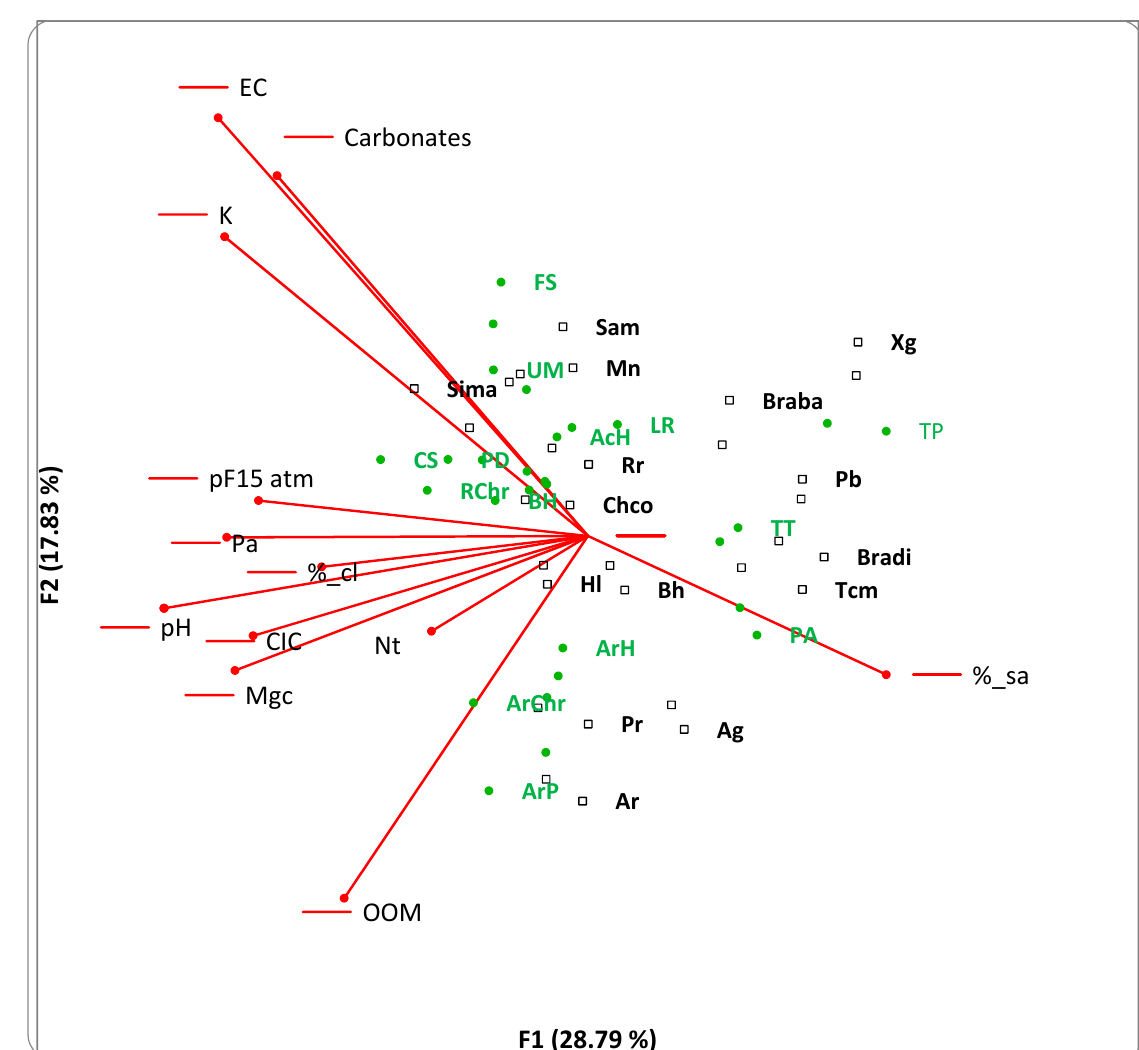
Figure 2. Canonical correspondence analysis (CCA) (axes F1 and F2: 46.62%). This figure shows the dominant species of each plant association, together with the associations and edaphic attributes. CCA analysis. Ag = Aegilops geniculata Roth; Ar = Anacyclus radiatus Loisel; Bh = Bromus hordeaceus L.; Chco = Glebionis discolor (d’Urv.) E. Cano et al. (= Chrysanthemum coronarium L. var. discolor d’Urv.); Hl = Hordeum leporinum Link; Mn = Malva neglecta Wallr.; Pr = Papaver rhoeas L.; Pb = Plantago bellardii All.; Rr = Raphanus raphanistrum L.; Sam = Sinapis alba L. subsp. mairei (H. Lindb.) Maire; Sima = Silibum marianum (L.) Gaert.; Tcm = Taeniatherum caput-medusae (L.) Nevski; Xg = Xolantha guttata (L.) Raf.; AcH: Anacyclo clavati- Hordeetum leporini . ArH: Anacyclo radiati-Hordeetum leporini . ArP: Anacyclo radiati-Papaveretum rhoeadis. ArChr: Anacyclo radiati-Chrysanthemetum coronarii . BH: Bromo scoparii-Hordeetum leporini . CS: Carduo bourgeani-Silybetum mariani. FS: Fedio cornucopiae-Simapietum mairei . LR: Linario spartei-Raphanetum raphanistri . PD: Papaveri rhoeadis-Diplotaxietum virgatae . PA: Plantagini bellardii-Aegilopetum geniculatae . RChr: Resedo albae-Chrysanthemetum coronarii . TT: Trifolio cherleri-Taeniatheretum capitis-medusae . TP: Trifolio cherleri-Plantaginetum bellardii . UM: Urtico urentis-Malvetum neglectae . (See acronyms of edaphic factors in Table 2).